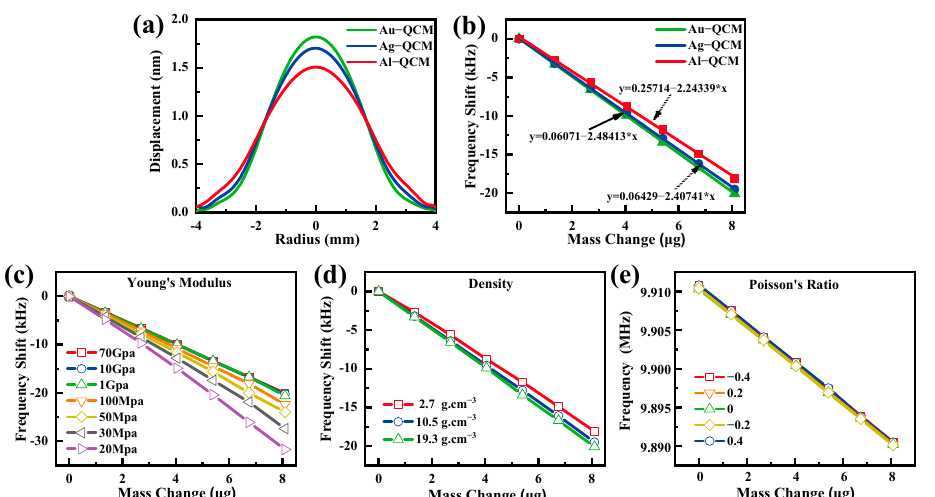
Figure 5. The simulation results of ( a ) the displacement and ( b ) sensitivity of Au-QCM, Ag-QCM, and Al-QCM. QCM’s simulation sensitivity at a different ( c ) Young’s modulus, ( d ) density, and ( e ) Poisson’s ratio.